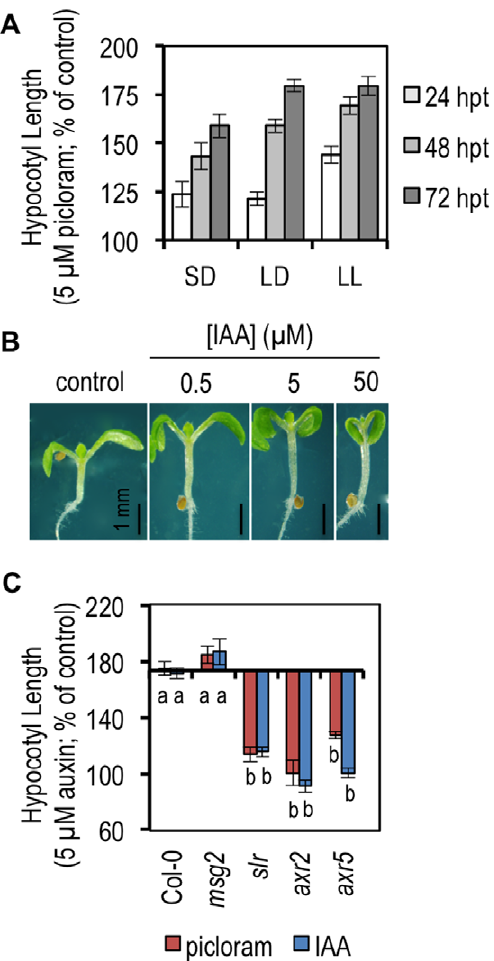
Figure 1. Auxin promotes hypocotyl elongation in light-grown seedlings. Auxin promotes hypocotyl elongation in a range of day- length conditions. Average hypocotyl length of wild-type seedlings grown in short days (SD; 8/16), long days (LD; 16/8) or constant light (LL) and treated with 5 m M picloram was determined following 24, 48, or 72 hours of auxin treatment. Hypocotyl length on auxin is shown as a percentage of length on control medium. Error bars indicate standard error. (B) Auxin response in seedlings increases with auxin concentra- tion. Images of aerial portions of individual 7 day-old seedlings were captured following 48 hours of IAA treatment at the indicated concentrations. (C) Hypocotyl auxin response requires auxin signaling. Average hypocotyl length of wild-type or aux/iaa mutant seedlings treated with 5 m M picloram (red bars) or IAA (blue bars) was measured following 48 hours of auxin treatment. Hypocotyl length on auxin relative to the untreated control is shown as in (a). Error bars indicate standard error. Statistical significance was determined using a Tukey HSD post hoc comparison among the means on the analysis of variance using type III sums of squares (p , 0.05).